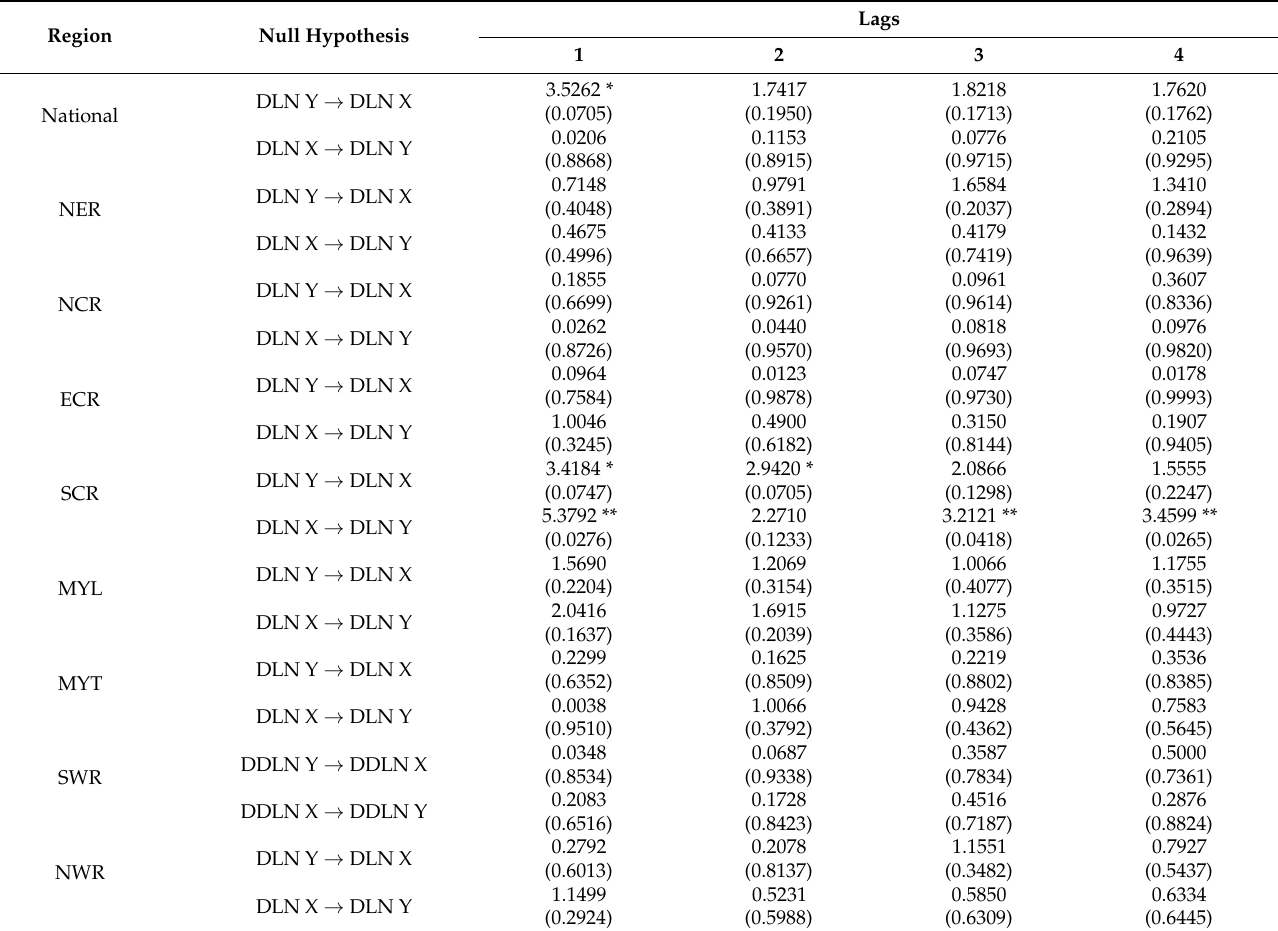
Table 7. Results of the Granger causality